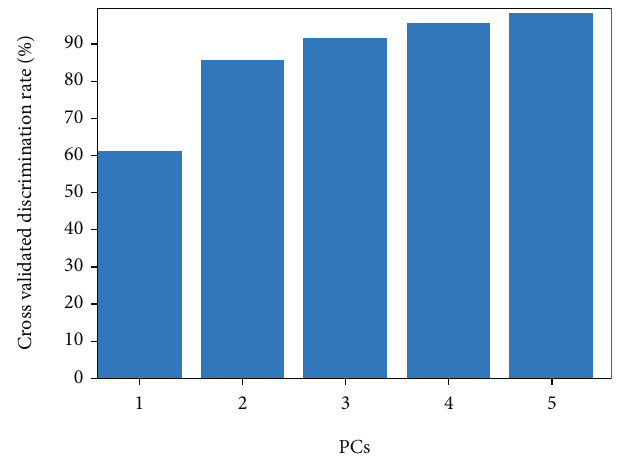
Figure 5: The k -fold cross-validation discrimination rates of second derivative preprocessed PLS-DA models at 5 Table 4: Overall performance of classi fi cation algorithms. Models